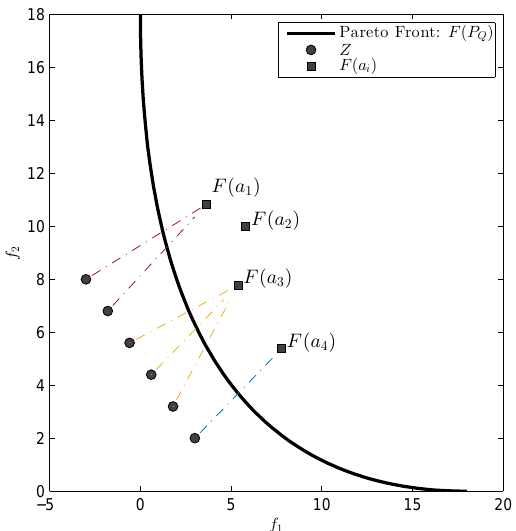
Figure 6. Potential problem of the Inverted Generational Distance (IGD) Newton method: if m l = 0 (here it is m 2 = 0) then the l -th sub-gradient is equal to zero, and a l will stay fixed under the Newton